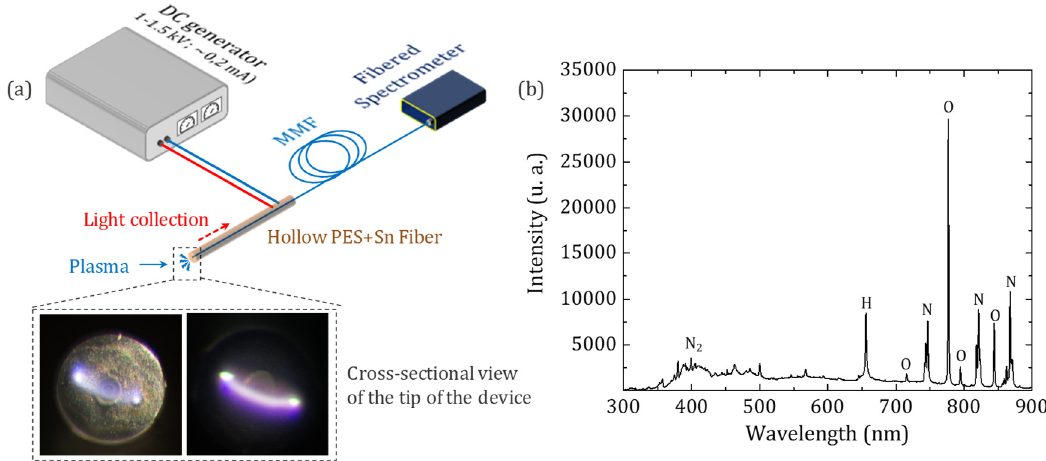
Figure 2. ( a ) Description of the experimental setup used for plasma spectroscopy involving an assembly of a polymer-metal and a silica fiber. The two pictures of the plasma (bottom left) generated at the tip of the assembly are taken in different lighting conditions: white light illumination (left) and in the dark (right). ( b ) A typical spectrum collected from this proof-of-principle device.